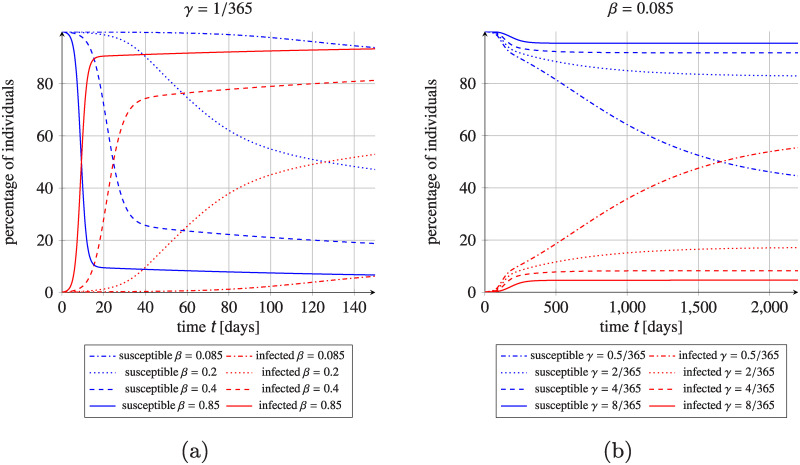
Effect of the change of SIS parameters on MRSA network-wide prevalence.(a) Effect of the change of the transmission rate on the percentage of susceptible (blue) and infectious (red) individuals in the healthcare facilities network. (b) Effect of the change of the recovery rate on the percentage of susceptible (blue) and infectious (red) individuals in the healthcare facility network. Initial fraction of the colonized individuals is 0.1% uniformly distributed in the whole population. Sets of parameters being perturbations of the SIS reference values reported in Table 1 (set type: MRSA) as indicated in legends.